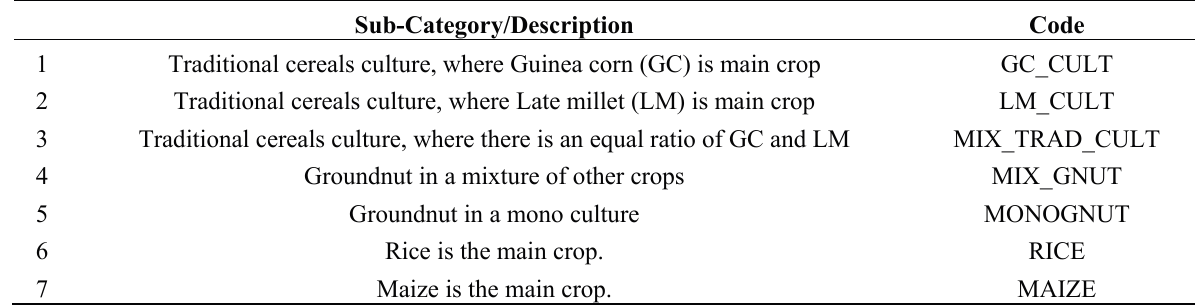
Table 1. Agricultural land-use choice classes.